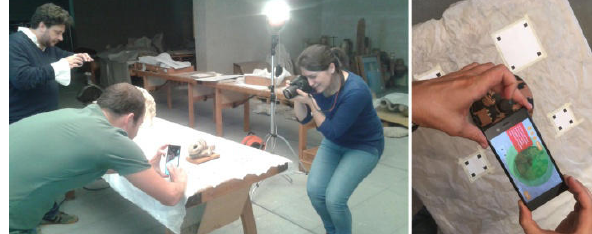
Figure 1. Acquisition phase done with different instruments: Digital Cameras used to prepare image dataset (SFM), on the right; SONY XZ1 smartphone used with the 3D Creator app, on the left.